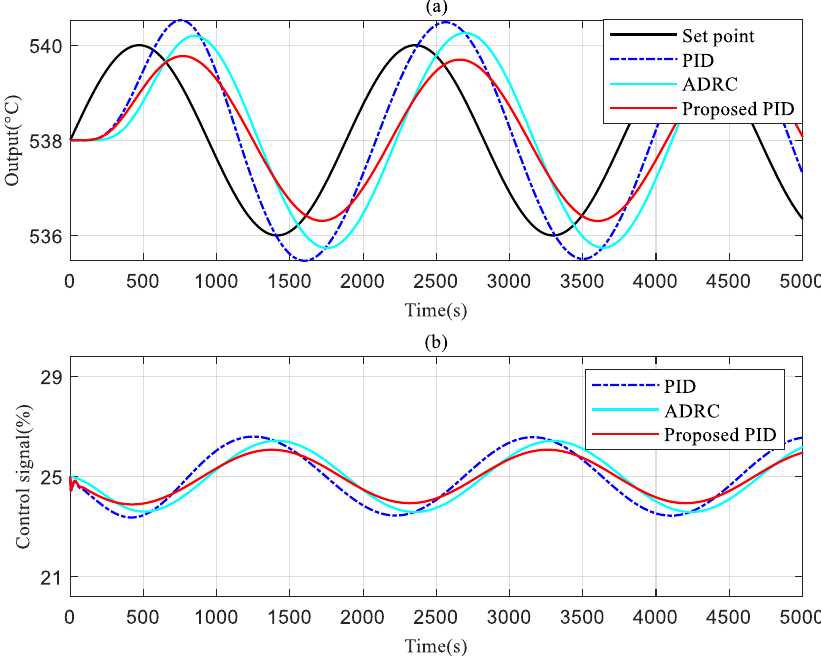
Figure 10. Set-point inusoidal tracking performance under an operating condition of 50% load ( a ): outputs, ( b ): control